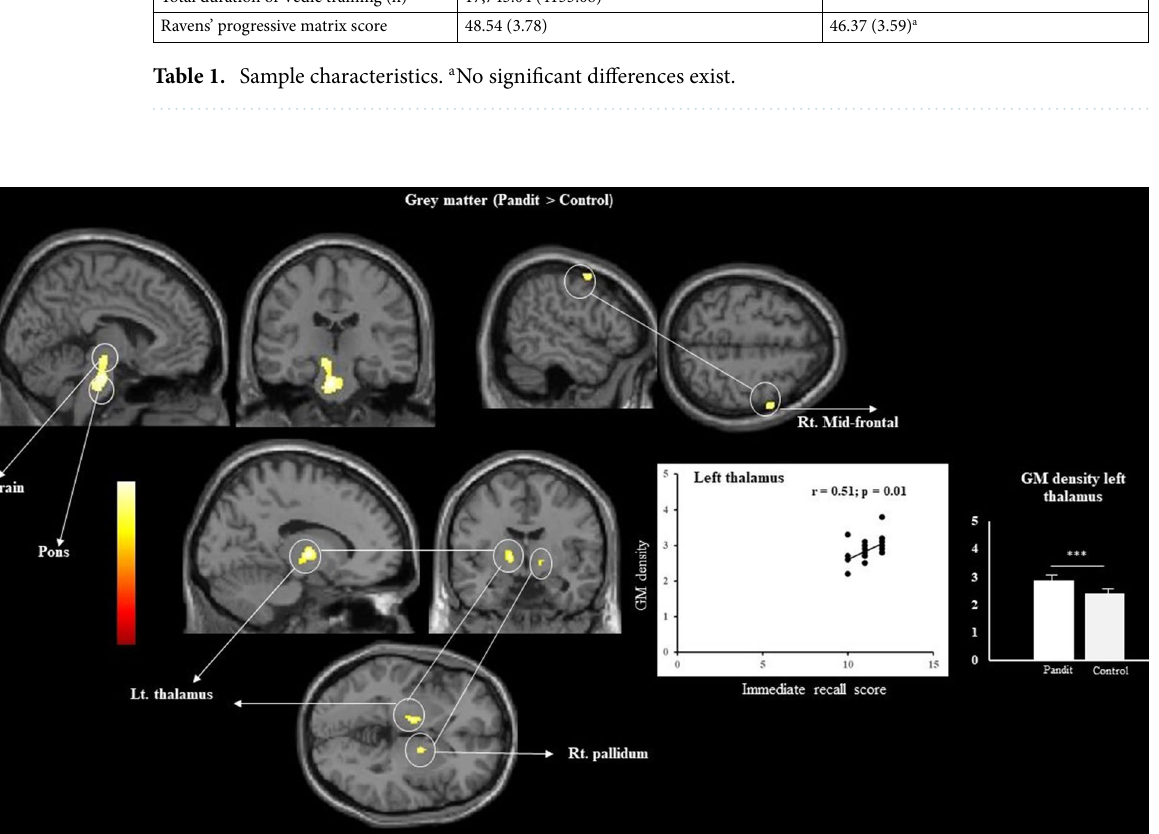
Figure 3 and Table 4 show an increased cortical thickness in the right temporal pole and right caudate, while Fig. 4 and Table 5 show increased gyrification in the left insula, left supplementary motor area (SMA), and the left superior medial frontal region in the Pandit group. We also examined the relationship between the LGI and CT findings. We created the mask regions based on the gyrification analysis and then calculated the group mean CT value and compared it between the groups. No